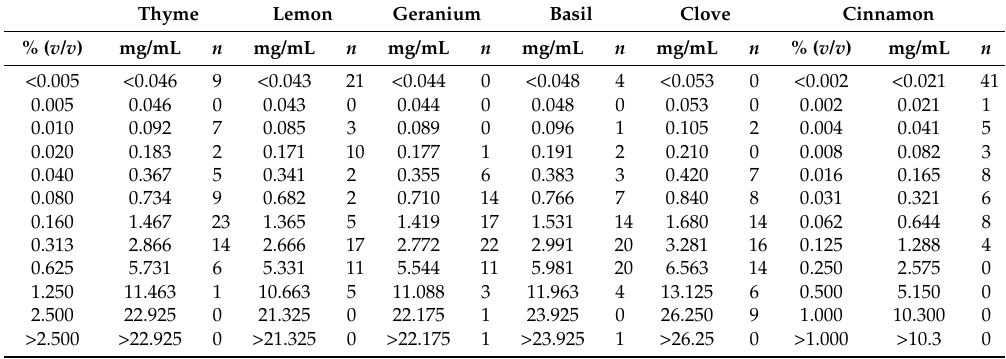
Table 4. Number of isolates with exact MFC value (% v / v ) of the selected essential oil in the group of 76 C. glabrata clinical